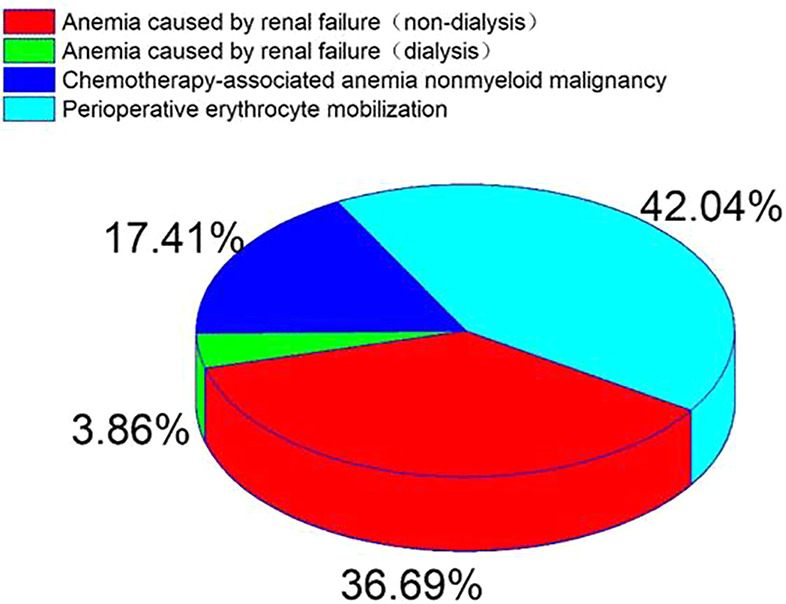
Percentage distribution of diseases in patients with EPO in accordance with indications from 2009 to 2018.